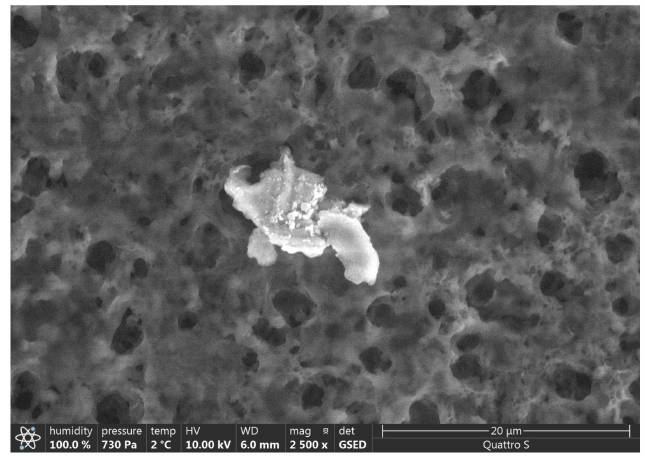
Figure 6. Illustration showing the magnification of Product J (2500 × ). A particle of >10 µ m was observed.